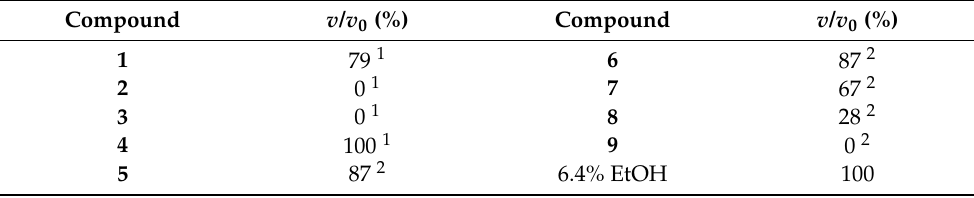
Table 1. Residual activity v/v 0 (%) of the α -PsGal after incubation with alkaloids 1–9. Compound v/v 0 (%) Compound v / v 0